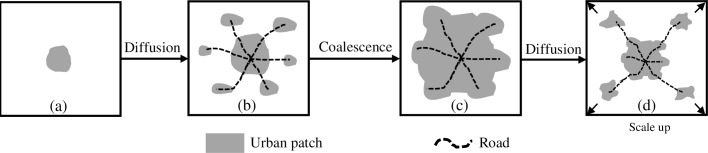
Hypothetical sequence of the spatial evolution of an urban area.